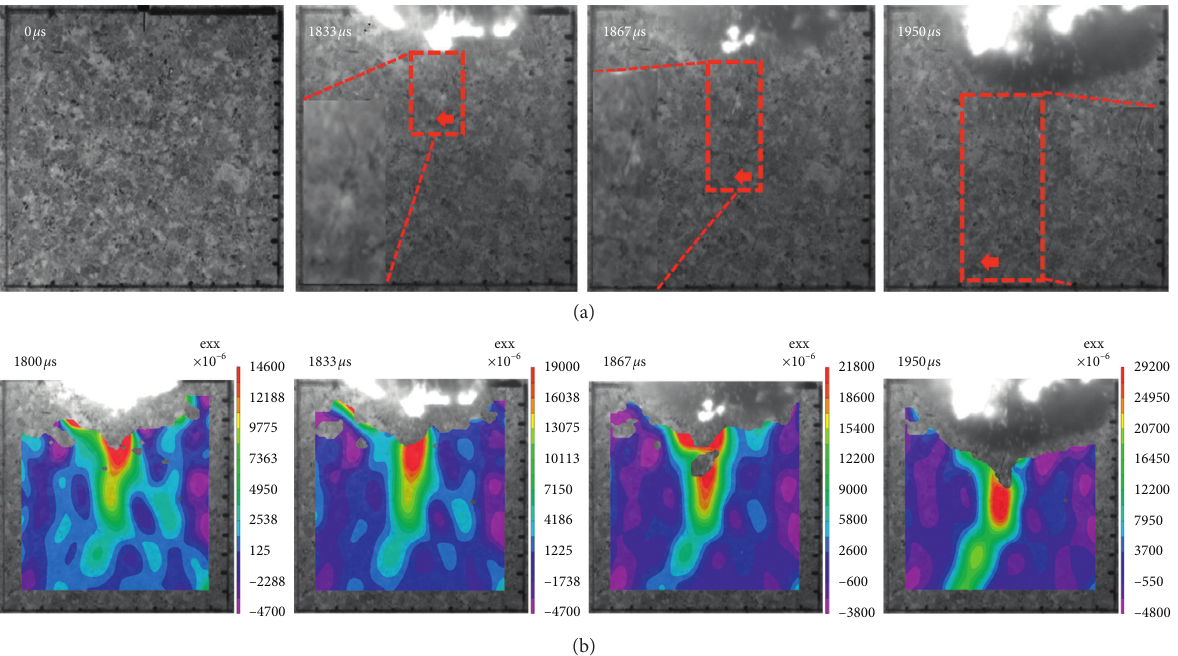
Figure 8: (a) Crack evolution and (b) full-field axial strain at different stages for test